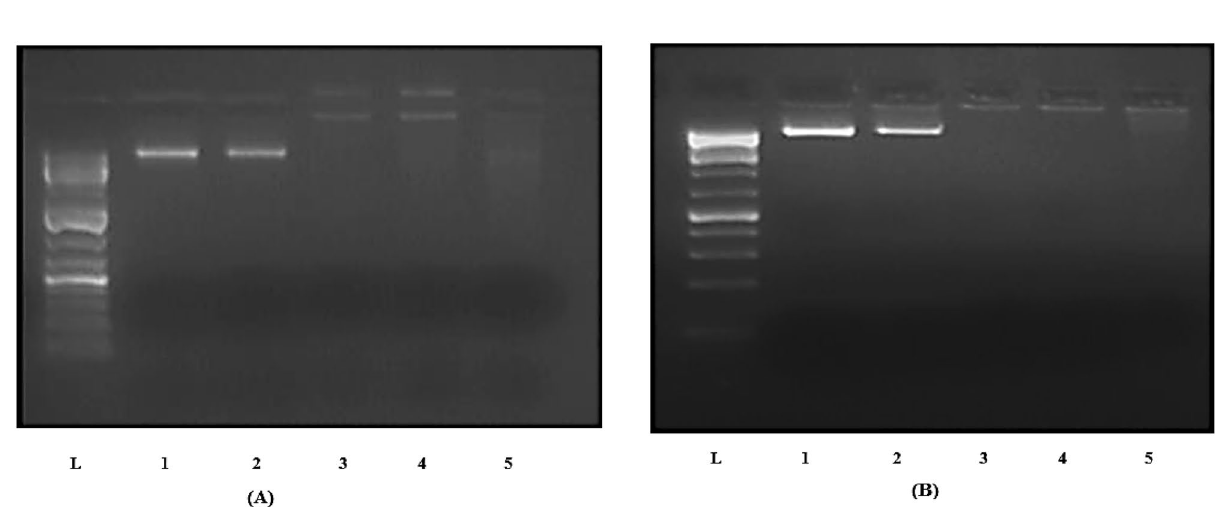
Figure 12. Electrophoretic separation of DNA induced by Cu(II) complex 24. ( A ) Fixed concentration of DNA with different concentrations of the complex (lane L- marker 1 kb DNA Ladder, lane 1: DNA control, lane 2: DNA + DMSO, lane 3: 400 ng DNA + 2 mg mL −1 of the complex, lane 4: 400 ng DNA + 1 mg ml −1 of the complex, lane 5: 400 ng DNA + 0.5 mg mL −1 of the complex). ( B ) Fixed concentration of complex with different concentrations of DNA (lane L-marker 1 kb DNA Ladder, lane 1: DNA control, lane 2: DNA + DMSO, lane 3: 200 ng DNA + 1 mg mL −1 of the complex, lane 4: 400 ng DNA + 1 mg mL −1 of the complex, lane 5: 800 ng DNA + 1 mg mL −1 of the